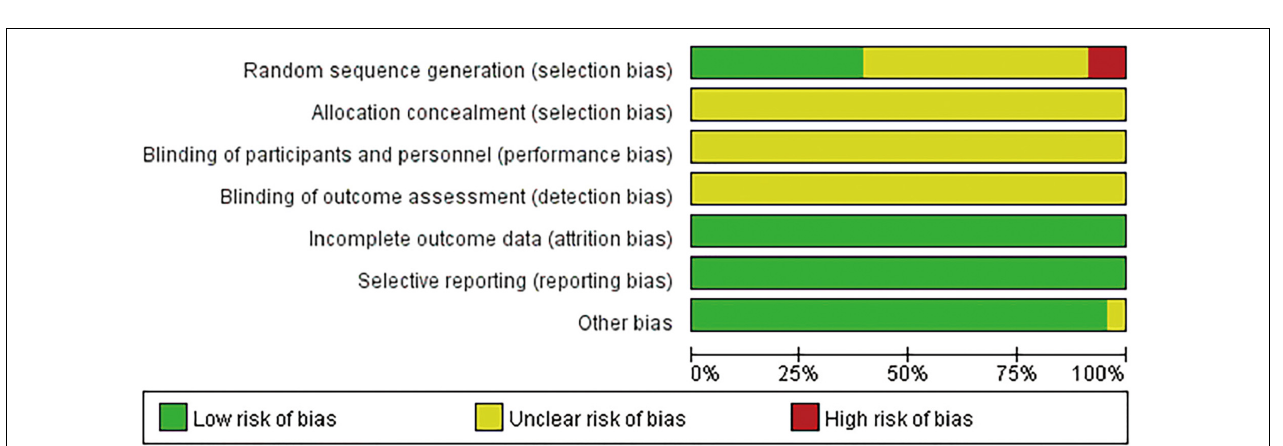
FIGURE 2 | Specific results of deviation assessment.